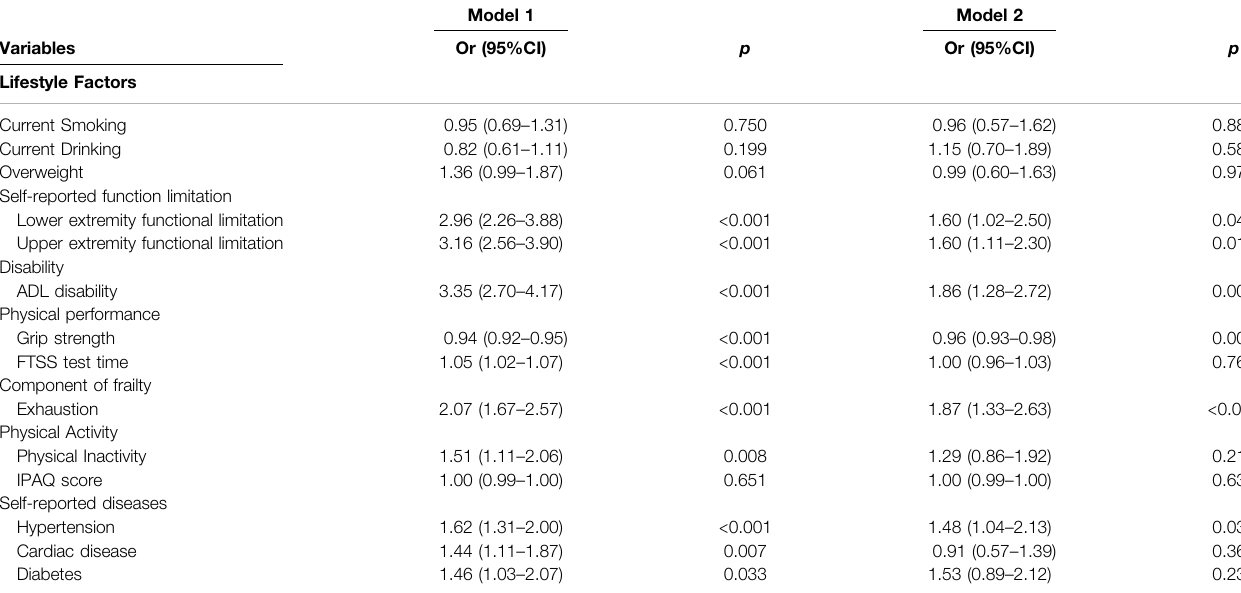
TABLE 2 | Associated factors for MCR.